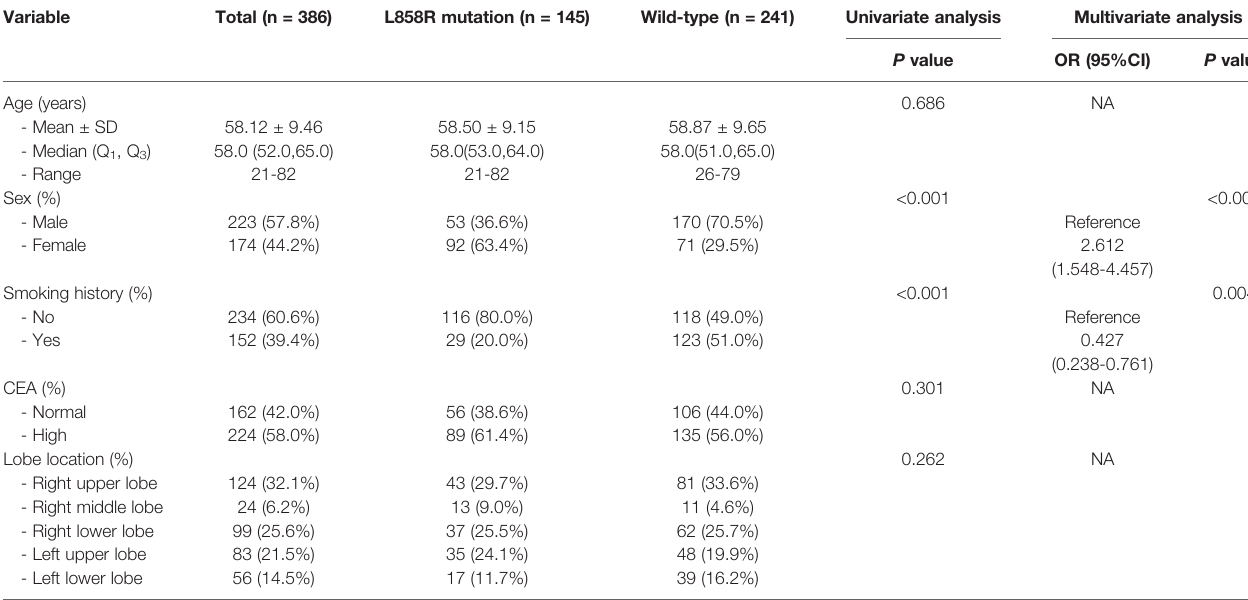
TABLE 2 | The relationship between clinical variables of patients and EGFR molecular subtypes (L858R mutation vs. Wild-type) in the training set.